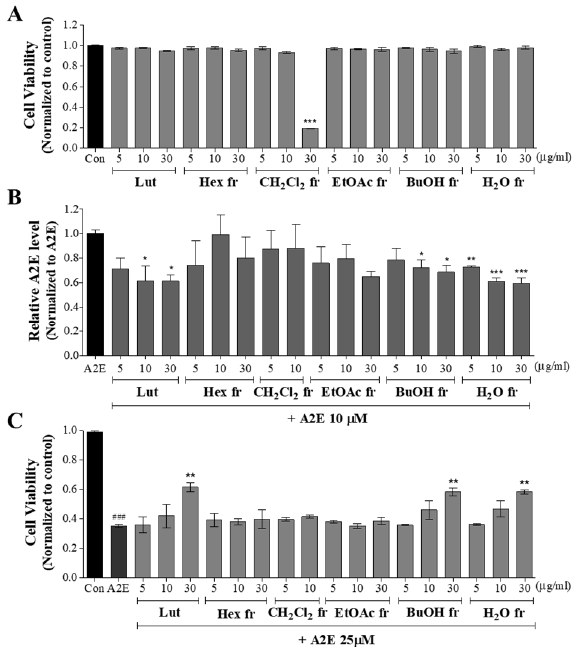
Figure 4. Suppressive effects of five fractions on A2E accumulation and A2E-induced cell death in ARPE-19 cells. ( A ) Cytotoxicity of five fractions to ARPE-19 cells. ( B ) Suppression of A2E accumulation in ARPE-19 cells by CBE. ( C ) Suppression of A2E-induced ARPE-19 cell death by CBE. The values represent the mean ± SD ( n ≥ 3). ### p < 0.001 vs. control group; * p < 0.05, ** p < 0.01, *** p < 0.001 vs. A2E group, one-way ANOVA with Tukey’s post hoc test. The suppressive effects of the fractions on A2E-induced cell death in ARPE-19 cells